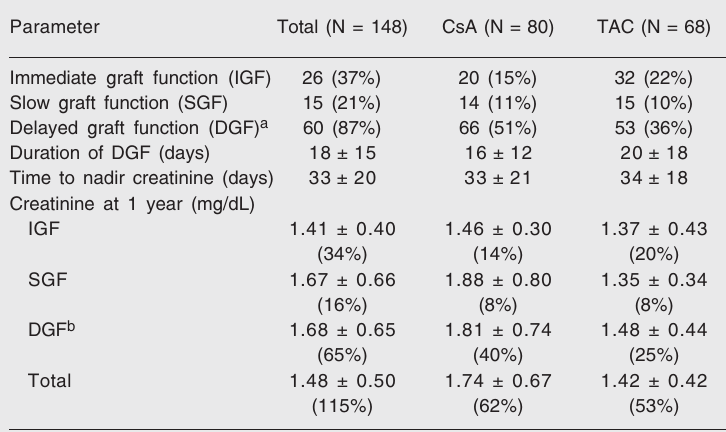
Table 3. Outcome of initial and 1-year graft